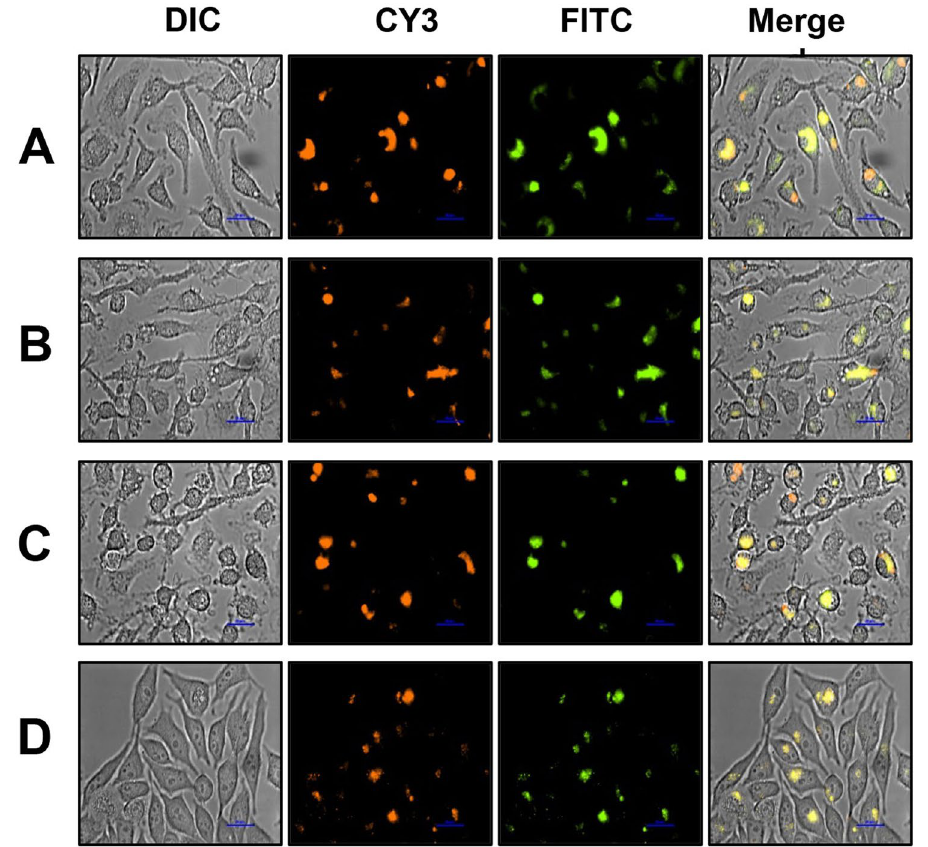
Figure 6. Induction of GFP in M . smegmatis MSOHG4 strain by intracellular organic hydroperxoides of mutant macrophages and epithelial cells. BMDM cells from Phox − / − , iNOS − / − , MPO − / − mice and HeLa epithelial cells were grown on glass coverslips and infected with M . smegmatis MSOHG4 bearing ohrR - pohr - gfpuv and phsp60 - rfp fusions for 4 h at 37 °C. After washing, the coverslips were examined under Nikon TiE Inverted Fluorescence Microscope with 60X objective. DIC, Cy3 and FITC indicate images obtained using these filters. MERGE indicates the merged images of DIC, CY3 and FITC. A, BMDM from Phox − / − mice; B, BMDM from iNOS − / − mice; C , BMDM from MPO − / − mice; D, HeLa